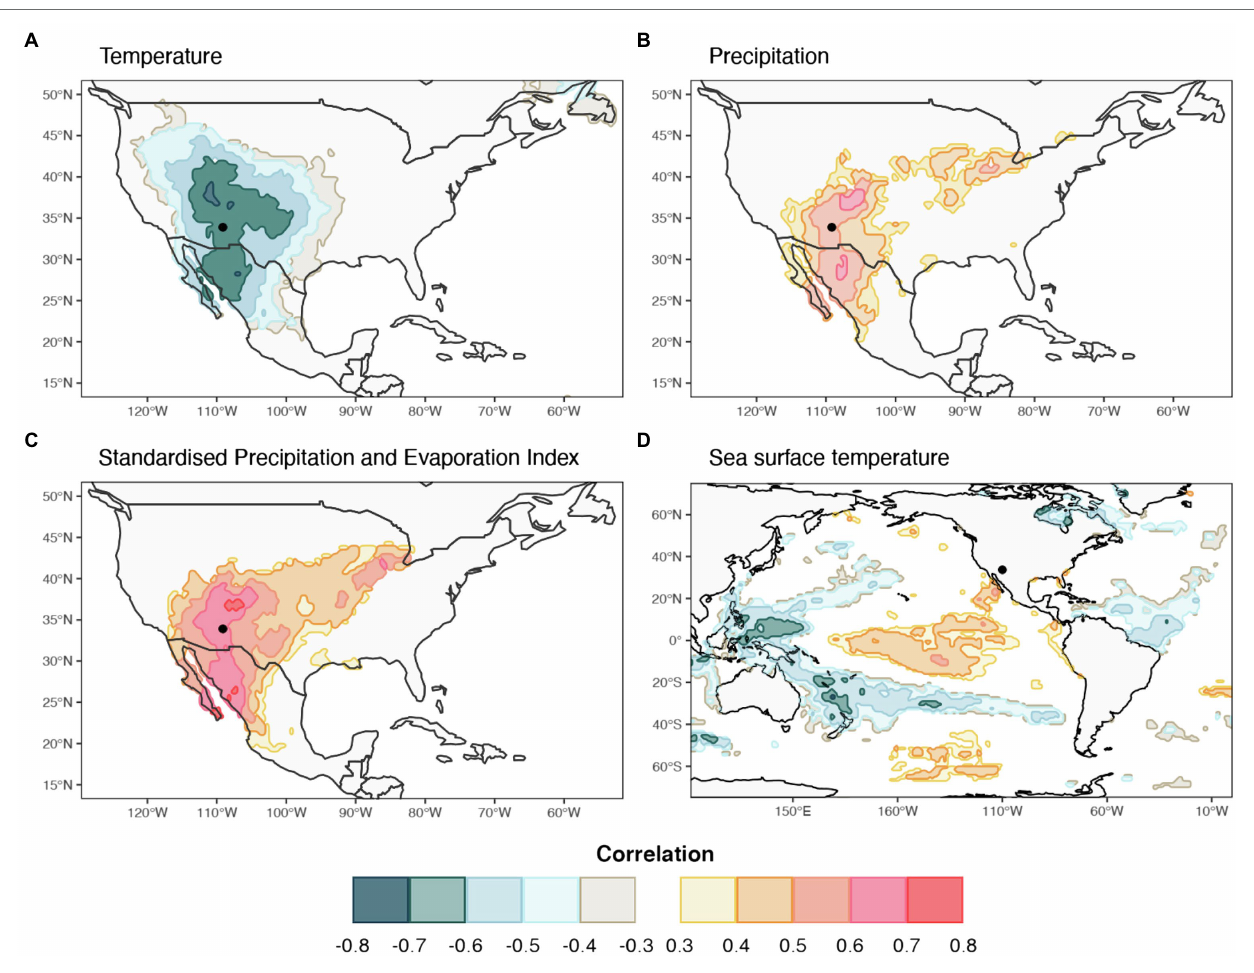
FIGURE 7 | Spatial field correlation maps between selected radial lumen diameter sector chronologies and climate parameters for the period 1981–2015. Sector I chronology was correlated against (A) mean October to January temperature ( C ) October to January one-month Standardized Precipitation and Evaporation Index, and (D) October to January sea surface temperature. Mean chronology for sectors I-V was correlated against (B) November to January precipitation. The location of the study site is identified by a black dot. Colored areas show correlations significant at p <